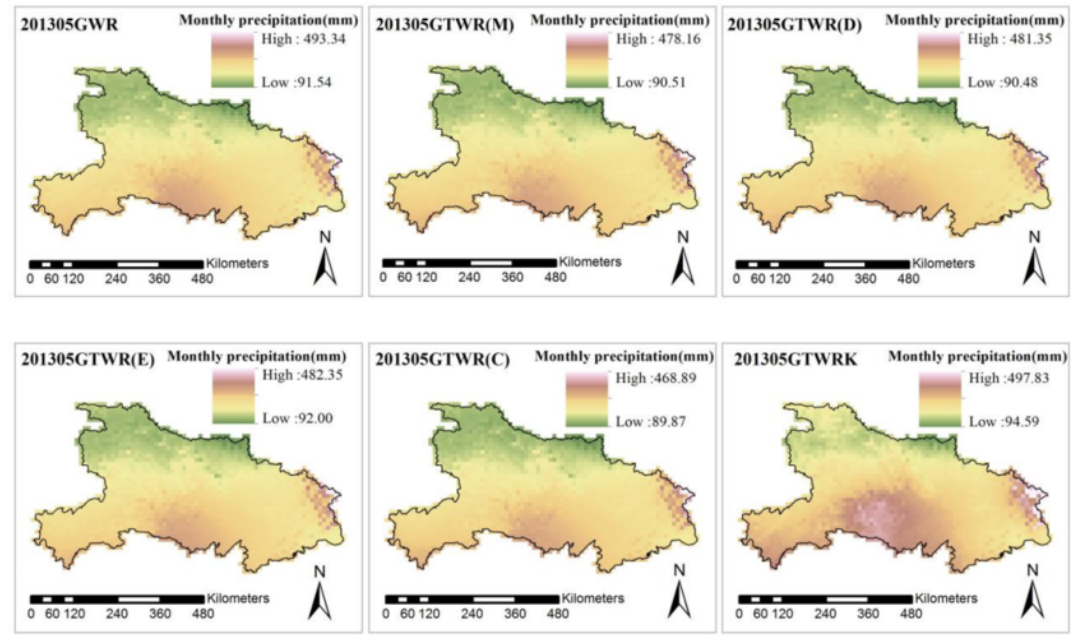
Figure 5. The interpolation distribution maps for GWR, GTWR(M), GTWR(D), GTWR(E), and GTWR(C) corresponding to May 2013.